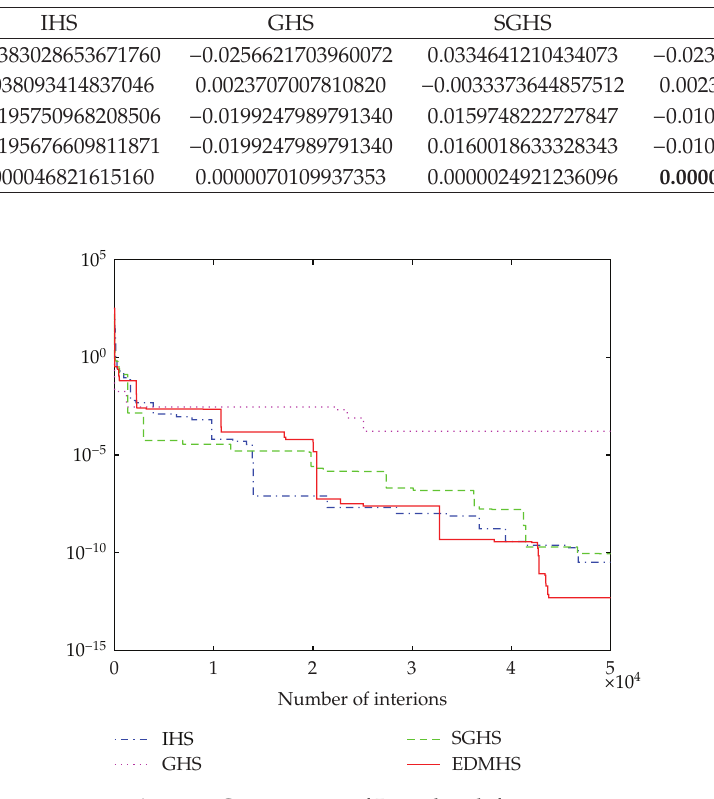
Figure 1: Convergence of Rosenbrock function.